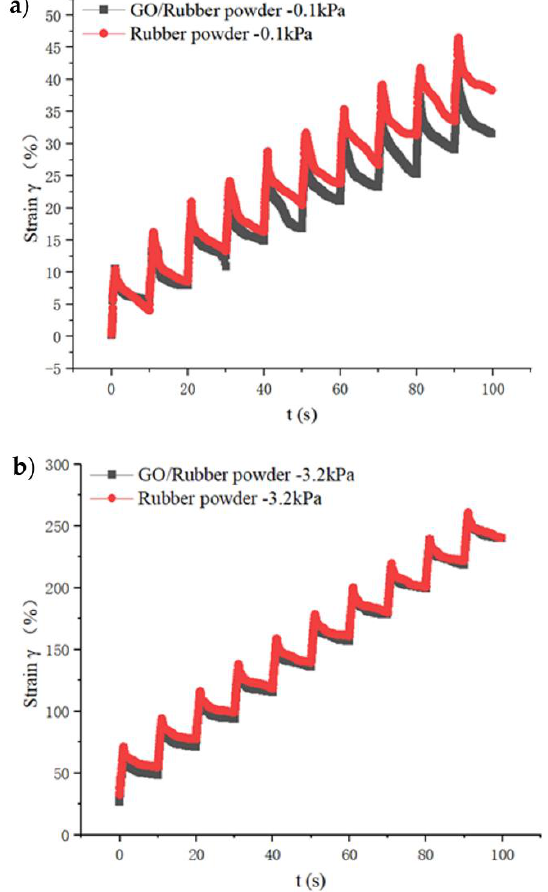
Figure 6. Multi-stress creep recovery test results: ( a ) results of multi-stress creep recovery test of modified asphalt (0.1 kPa stress level); ( b ) results of multi-stress creep recovery test of modified asphalt (3.2 kPa stress level).